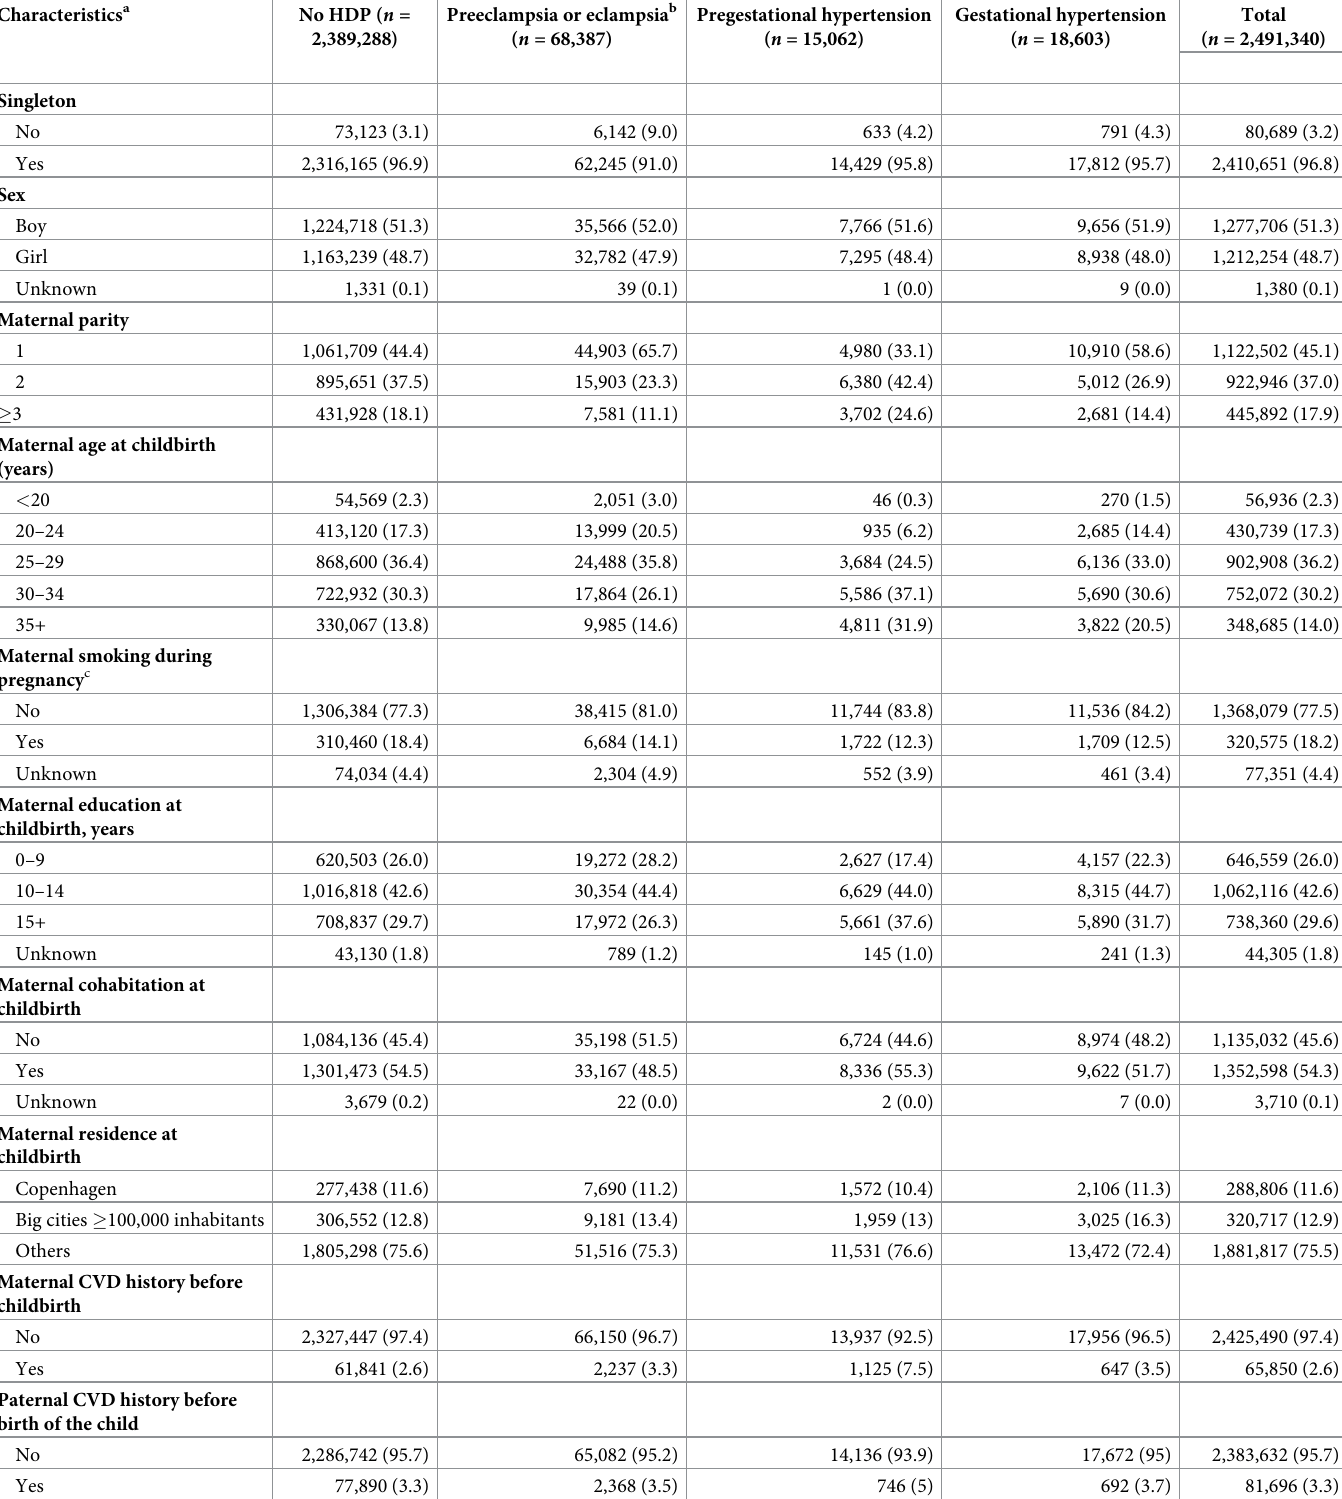
Table 1. Baseline characteristics according to offspring’s exposure to maternal HDP, Denmark, 1977–2018. Characteristics